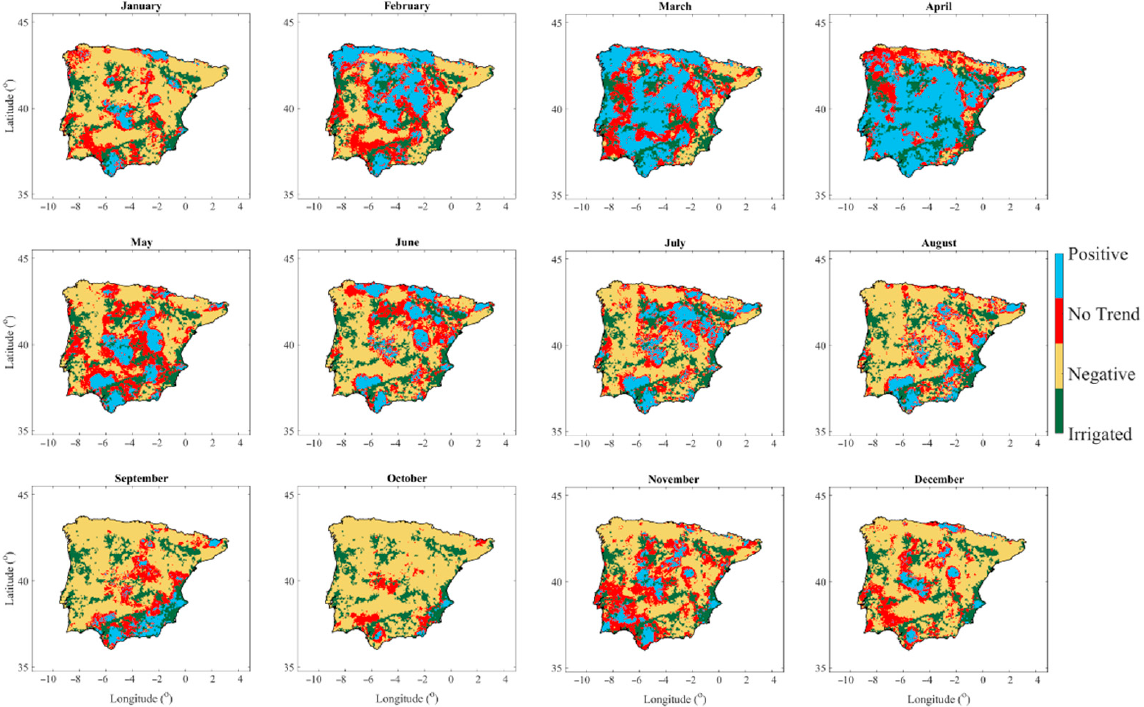
Figure 4. Monthly results of the soil moisture anomalies trends obtained with ERA5 data (daily scale).